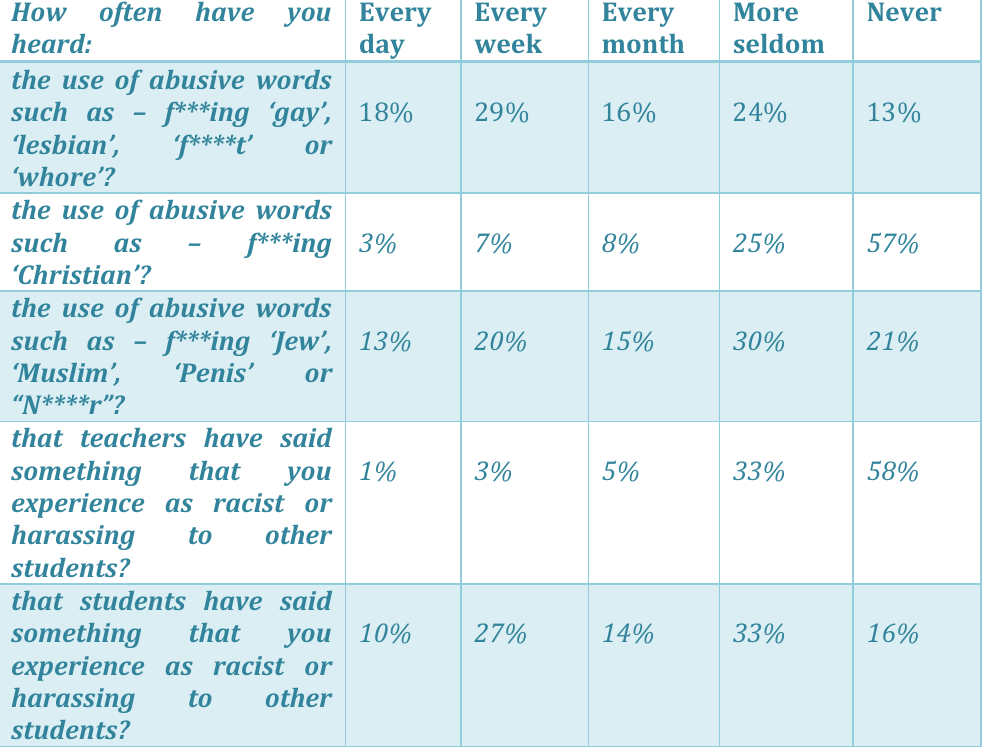
Table 1. Overview of secondary students’ perceptions (N=382) on their experience of abusive